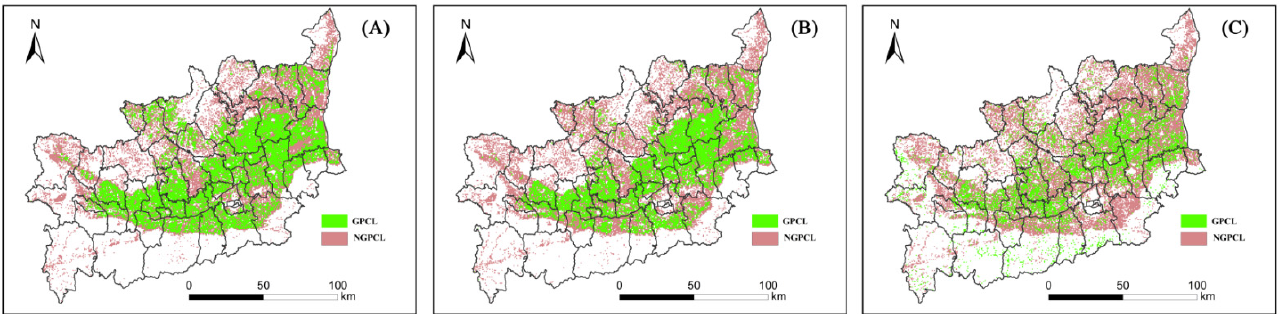
Figure 3. Spatial distribution of cultivated land of non-grain production (NGPCL) and cultivated land of grain production (GPCL): ( A ) 2000, ( B ) 2010, and ( C ) 2019.